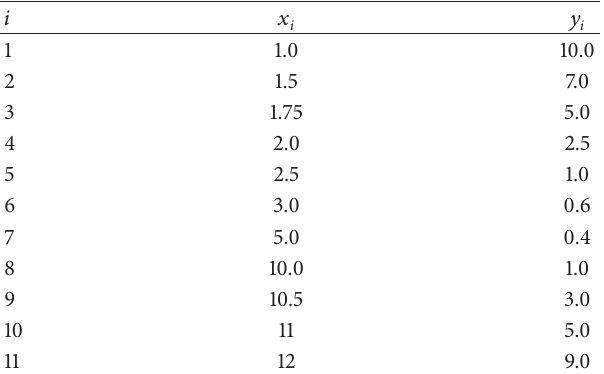
Table 3: A convex data